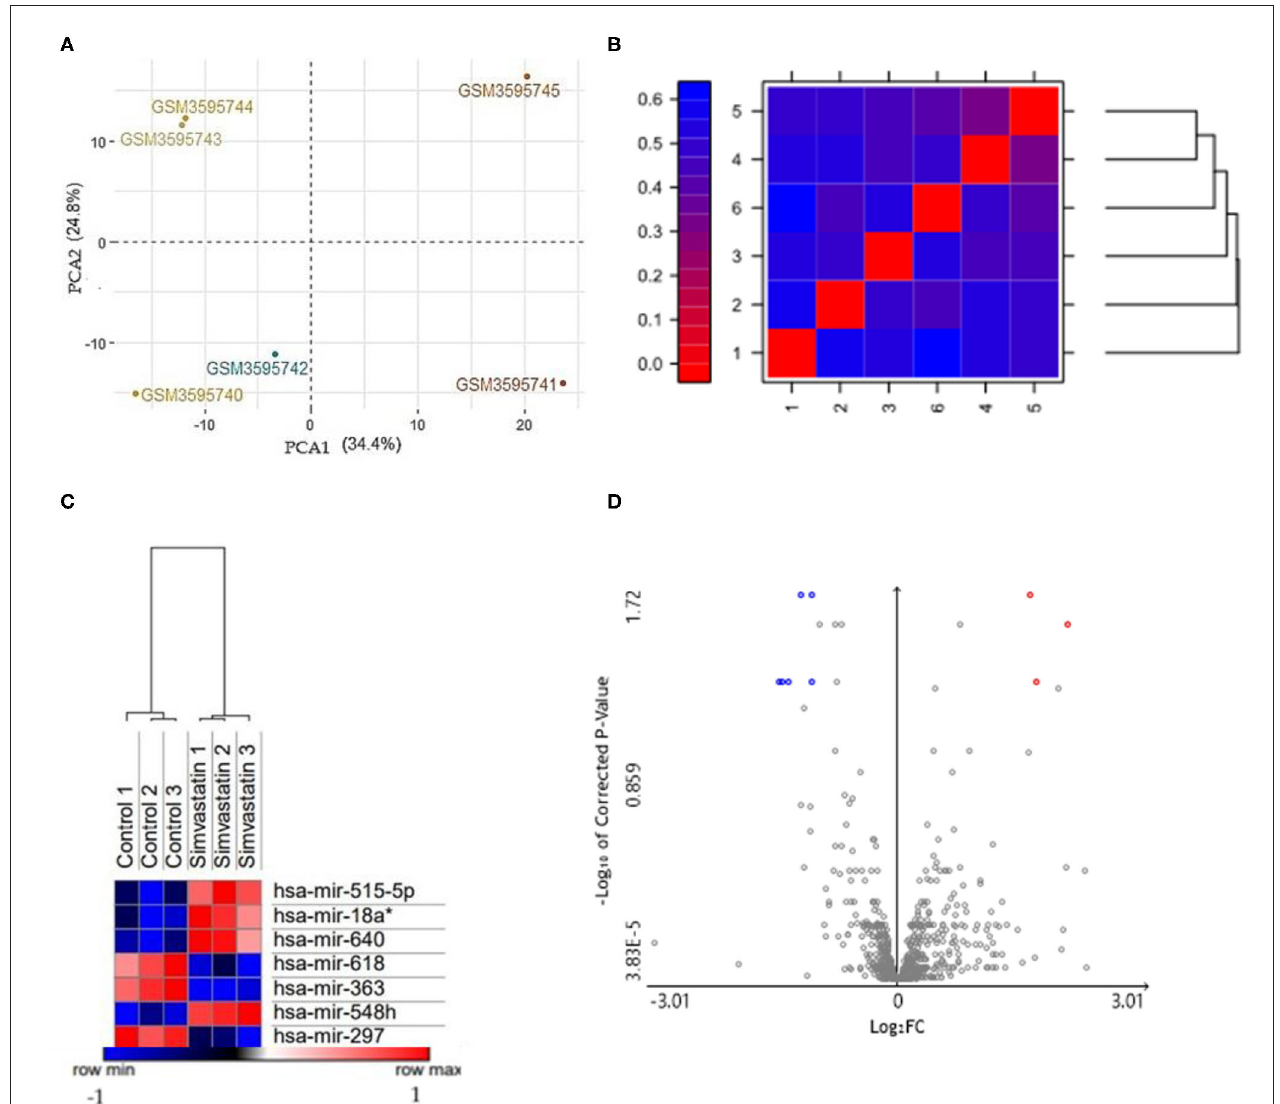
FIGURE 1 | (A) PCA based on microarrays showed that samples were grouped. The HUVEC control (GSM3595740; GSM3595741; GSM3595742) and HUVEC cells treated with 10 µ M simvastatin (GSM3595743; GSM3595744; GSM3595745) were separated by PC2. (B) False color heat maps indicating distances between matrices. 1 (Control 1); 2 (Control 2); 3 (Control 3); 4 (Simvastatin 1); 5 (Simvastatin 2); 6 (Simvastatin 3). (C) Hierarchical clustering heat maps with differentially expressed miRNAs in both conditions: control and simvastatin treated. In the graph, the red samples represent the highly expressed values while the blue ones show the low expressed values. The values are expressed in Log2. (D) Volcano plot of the differentially expressed miRNAs. The gray points represent genes with no significant difference. The red points represent upregulated genes screened based on the fold change > 1.0 and a corrected p -value of < 0.05. The green points represent downregulated genes screened based on the fold change > 1.0 and a corrected p -value of < 0.05.